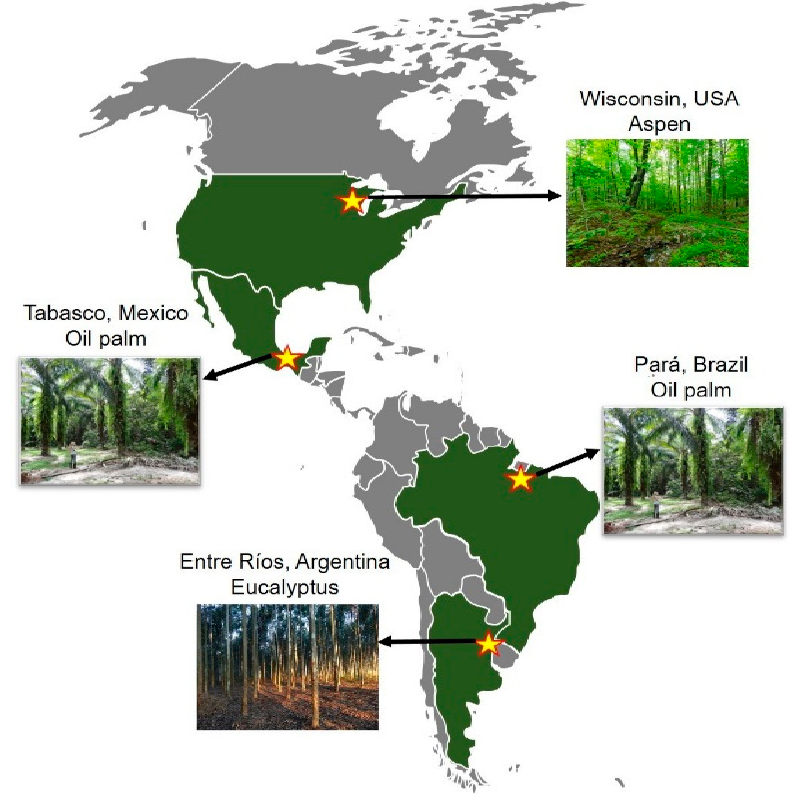
Figure 1. Location of the four study sites where ecological and social data were gathered for this paper, and type of bioenergy feedstock examined at each site: Aspen in Wisconsin, USA; oil palm in Tabasco, Mexico and Pará, Brazil, and eucalyptus in Entre Ríos, Argentina.